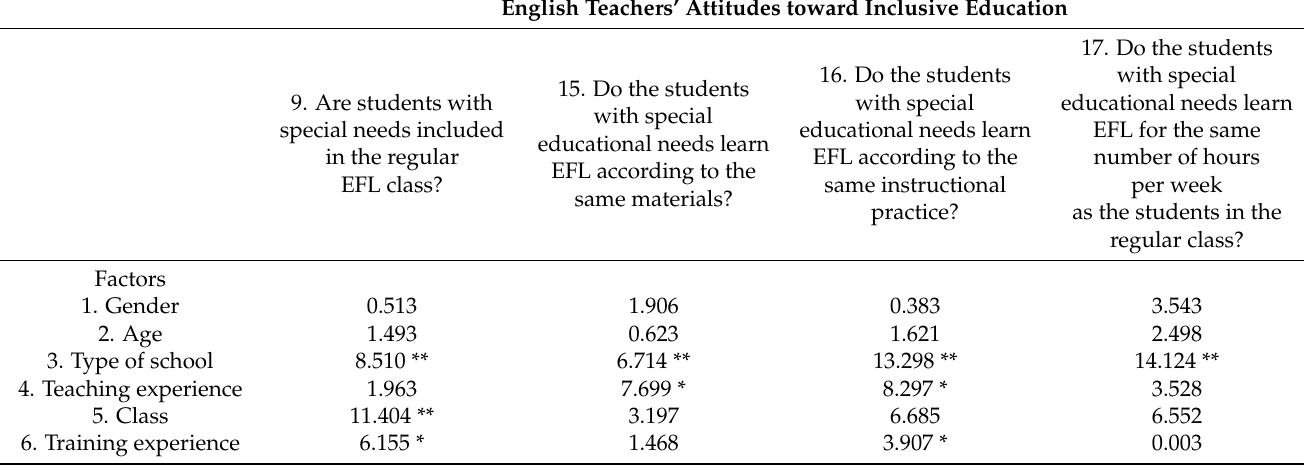
Table 4. The results of the chi-square